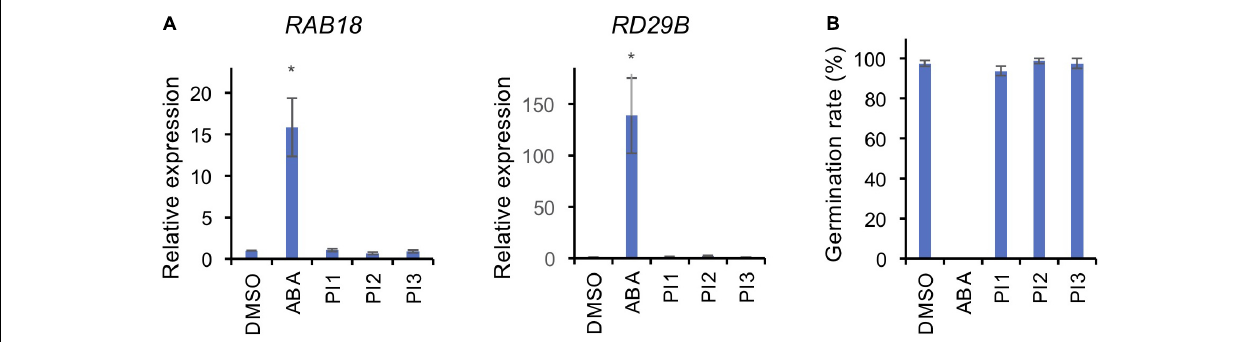
Frontiers in Plant Science |